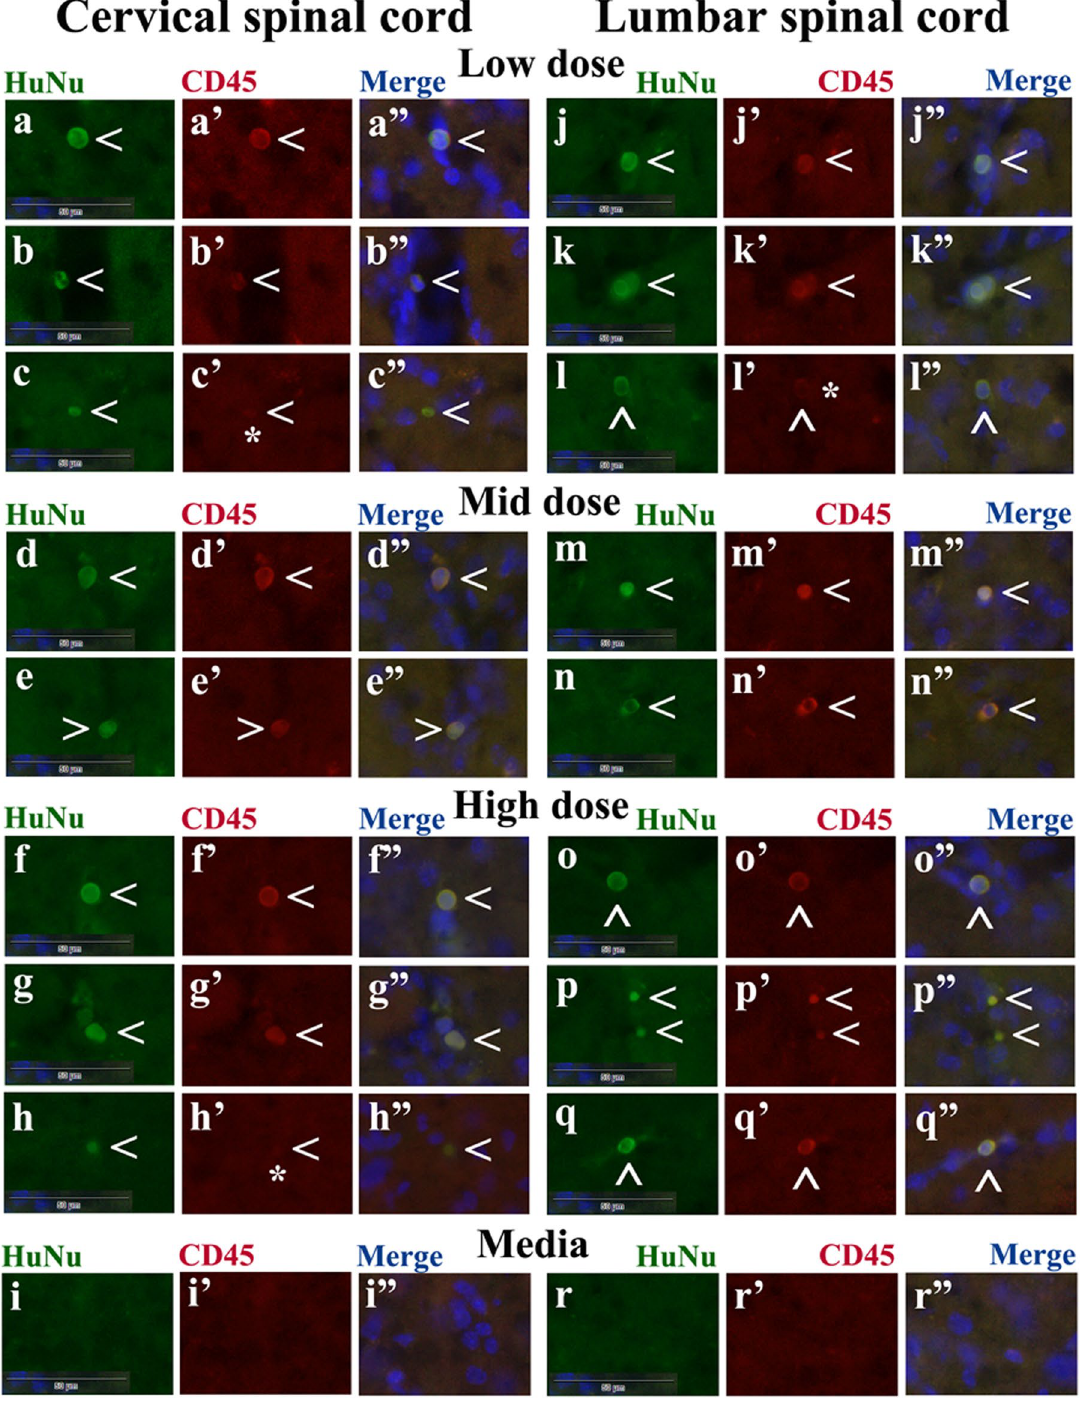
Figure 3. Immunochistochemical staining for HuNu and CD45 in the cervical and lumbar spinal cords of G93A mice receiving different cell doses. Double immunohistochemical staining with human-specific nuclei (HuNu) and CD45 of the cervical spinal cord showed immunopositive cells expressing HuNu + /CD45 + antigens (green, red, arrowhead) in mice treated with low ( a –b”), mid ( d –e”), and high ( f –g”) cell doses. These cells display predominantly rounded morphology and are located within the capillary lumen. A few cells were HuNu + /CD45 − ( c –c”, h –h”, asterisk) and are found some distance from blood vessels. Similarly, in the lumbar spinal cords, immunoexpression of HuNu + /CD45 + cells (green, red, arrowhead) was noted in all cell-treated mice: low ( j –k”), mid ( m –n”), or high ( o –q”) cell doses. Some cells only immunoexpressed HuNu and were negative for CD45 ( l –l”, asterisk). No cells expressing HuNu or CD45 were determined in the cervical ( i –i”) or lumbar ( r –r”) spinal cord from media-injected mice. Images are merged with DAPI. Scale bar in ( a –r”) is 50 µ